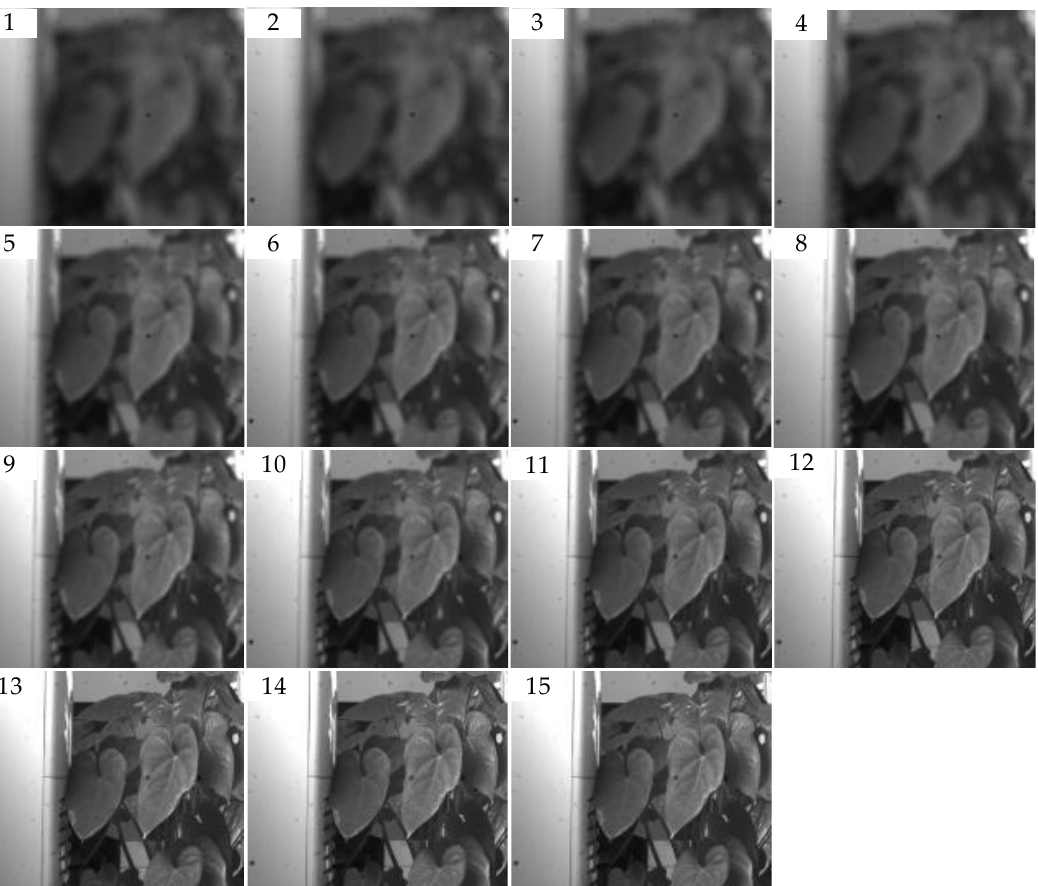
Figure 4. Defocused image sequence for comparison. Sub-figures (1 – 15) shows the imaging effect of the same target at different degrees of defocus. The first image is the most defocused, and the 15th image is the clearest.